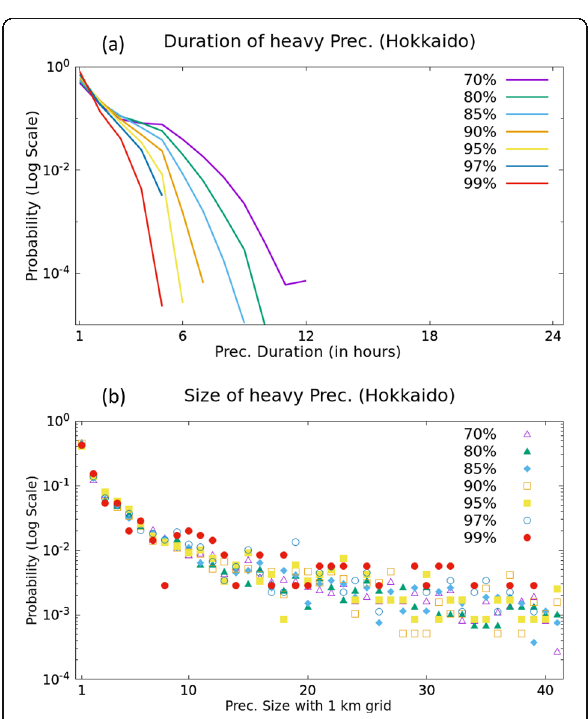
Fig. 9 a Duration and b size of heavy precipitations with different thresholds considering three typhoons (Typhoon Chanthu, Typhoon Mindulle, and Typhoon Kompasu) together over